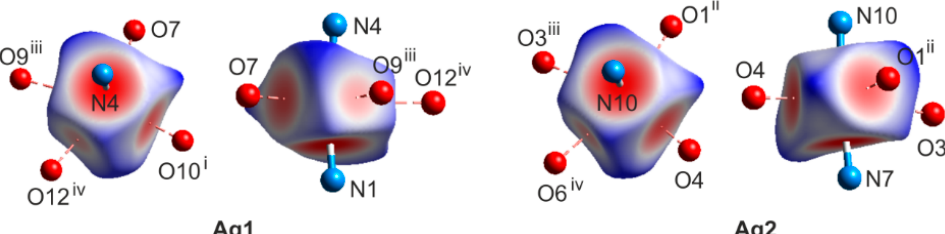
Figure 4. Two different orientations of the Hirshfeld surface of the metallic center of Ag1 and Ag2 with a normalized contact function (d norm ) mapped onto it. Symmetry codes: i x − 1, y − 1, z; ii x + 1, y + 1, z; iii 1 − x, 1 − y, 2 − z; iv 2 − x, 1 − y, 2 − z.